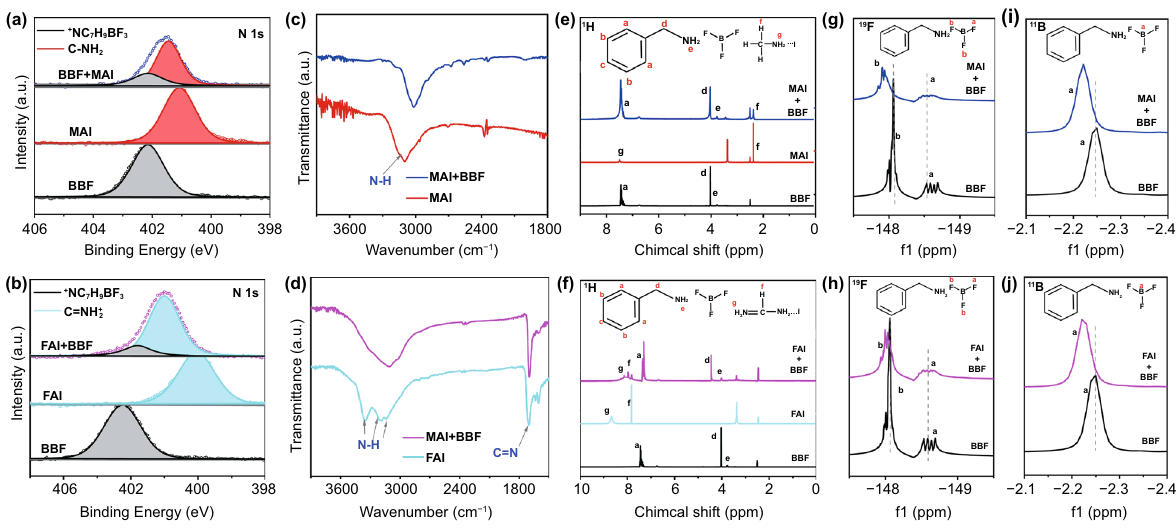
Fig. 2 N 1s XPS of a BBF, MAI and BBF + MAI and b BBF, FAI and BBF + FAI. FTIR of c MAI, MAI + BBF and d FAI, FAI + BBF. 1 H NMR of e BBF, MAI and BBF + MAI and f BBF, FAI and BBF + FAI, 19 F NMR of g BBF, MAI + BBF and h BBF, FAI + BBF, 11 B NMR of i BBF, MAI + BBF and j BBF, FAI +